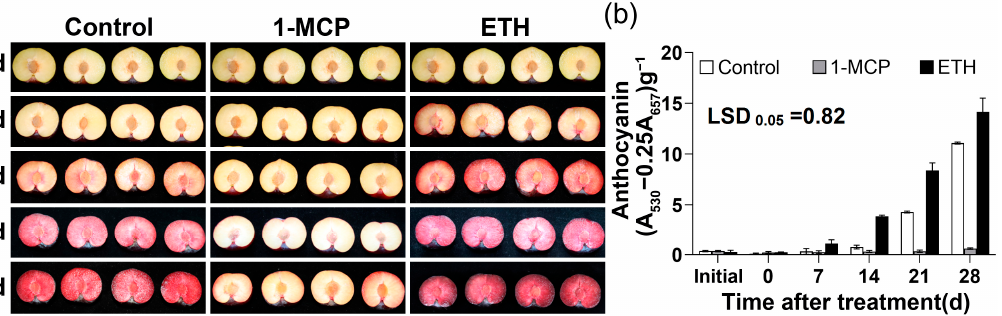
Figure 4. Effects of 1-MCP (1.0 µ L L − 1 ) and ETH (100.0 µ L L − 1 ) treatments on the changes of flesh color ( a ) and anthocyanin content ( b ) of ‘Friar’ plum fruit stored at 10 °C. “Initial” represents the time point before ethylene and 1-MCP treatments. The image of fruits on initial day is omitted in ( a ) and no obvious difference with that on day 0. The vertical bar represents the standard error while the LSD values show significant differences at the 0.05 level.